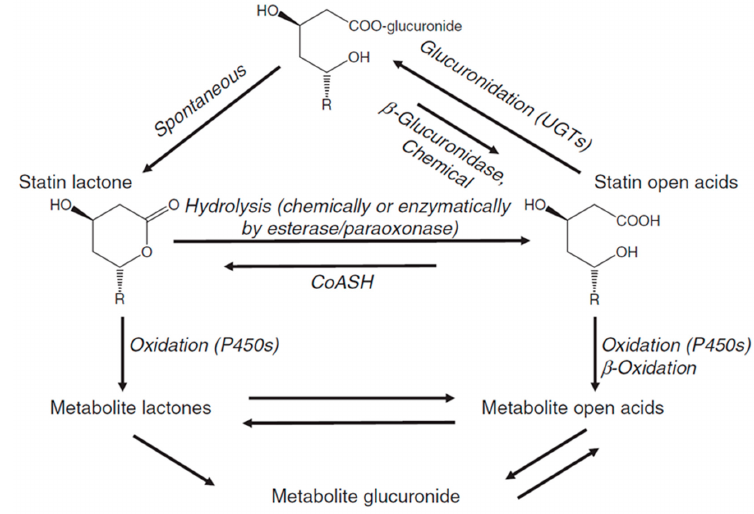
Figure 7. Lactonization or glucuronidation of statins. Conversion of statin acids into statin lactones is mediated by UDP-glucuronosyl transferase (UGT), or by the CoASH-dependent pathway. This reaction is reversible and occurs via hydrolysis of the lactone by esterases or paraoxonases. Statins have an oxidative interconversion pathway which involves the Cytochrom P450 family. Reprinted from Pharmacology and Therapeutics, 112, Shitara and Sugiyama, Pharmacokinetic and pharmacodynamic alterations of 3-hydroxy-3-methylglutaryl coenzyme A (HMG-CoA) reductase inhibitors: Drug–drug interactions and interindividual di ff erences in transporter and metabolic enzyme functions, 35, [86] Copyright (2006), with permission from